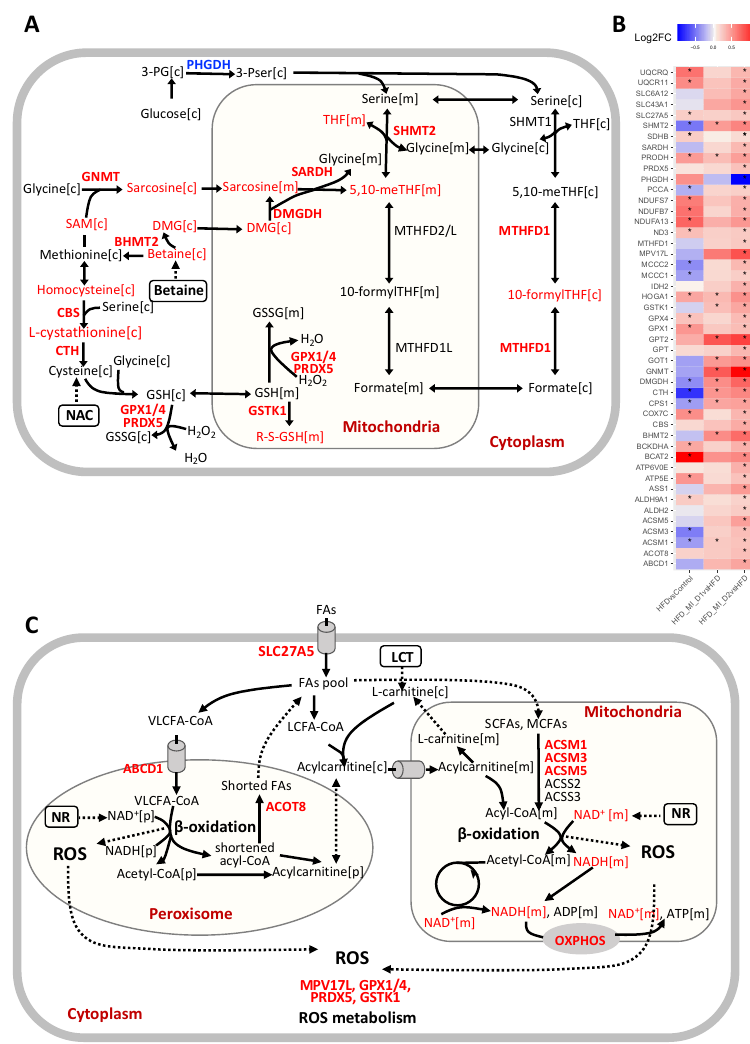
Figure 5. Significant increases (red) and decreases (blue) in genes and associated reporter metabo- lites in liver from hamsters in HFD + MI_D2 as compared to those in HFD group. ( A ) Reactions involved in one-carbon metabolism and transsulfuration pathway. ( B ) A summary of significantly expressed genes involved in one-carbon metabolism, transsulfuration pathway, fatty acid metabolism, oxidative phosphorylation (OXPHOS), BCAA degradation, TCA cycle and urea cycle. * Demon- strates the significance (adjusted p -value < 0.1). ( C ) Reactions involved in fatty acid metabolism in both mitochondria and peroxisome. Abbreviations: DMG, dimethylglycine; THF, tetrahydrofo- late; SCFAs, short-chain fatty acids; MCFAs, medium-chain fatty acids; LCT, L-carnitine tartrate; GSH, glutathione; GSSG, glutathione disulfide; 3-PG, 3-phosphoglycerate; 3PSer, 3-phosphoserine; SAM, S-Adenosyl-l-methionine. Additionally, we found that CMA supplementation increased the hepatic expression of genes involved in BCAA catabolism, including BCAT2 , BCKDHA , MCCC1 , MCCC2 , ALDH2 , ALDH9A1 and PCCA (Figures 5B and 6A). We also observed significantly enhanced hepatic expression of IDH2 and SDHB in TCA cycle. Increased TCA cycle and BCAA catabolism could indicate that the fatty acid oxidation and cellular respiration are enhanced as suggested by a previous study [51]. Moreover, we observed that the hepatic expression of genes involved in arginine biosynthesis ( GPT , GOT1 , GPT2 , CPS1 and ASS1 ) and genes involved in arginine and proline metabolism was significantly increased with the CMA supplementation. It has been reported that the down-regulation of CPS1 , the